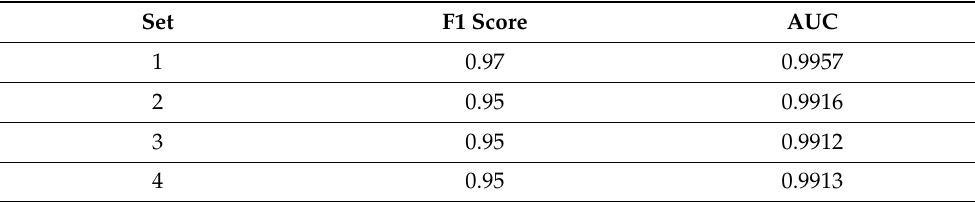
Table 5. Performance of LightGBM (with Bayesian optimization) on each column